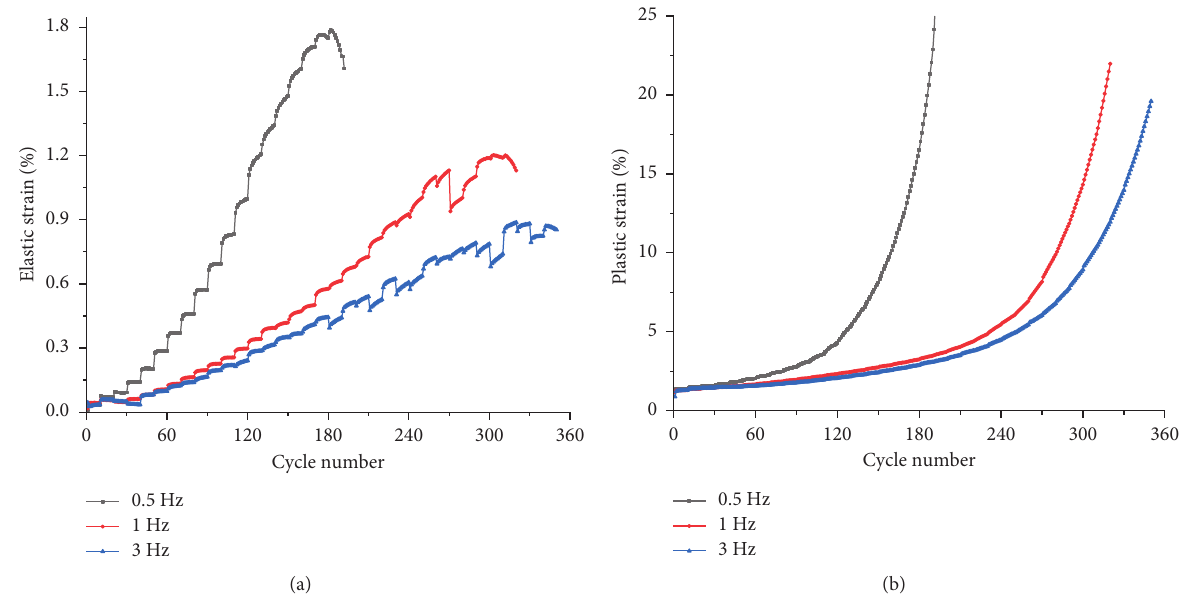
Figure 6: Elastic and plastic strain curves at different frequencies. (a) Elastic strain. (b) Plastic